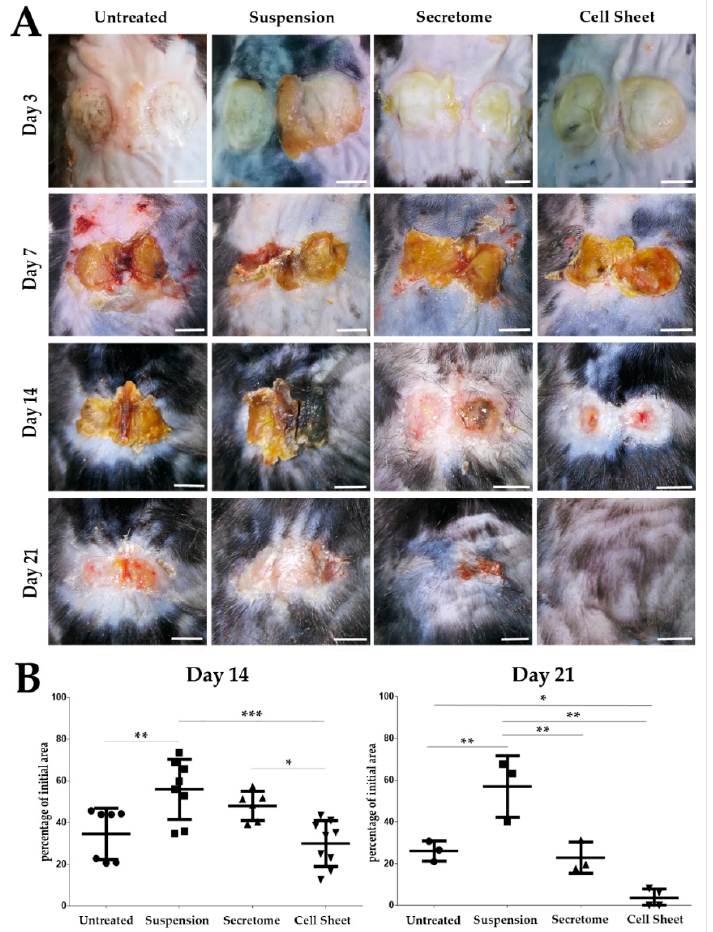
Figure 1. Macroscopic evaluation of pressure ulcer closure in experimental groups. ( A ) At Day 21 after cell sheet transplantation we found complete closure of the defect and onset of hair growth at the site of treated pressure ulcer. Scale bar represents 5 mm. ( B ) Results of defect relative area measurement as % of initial pressure ulcer at Days 14 and 21. Days 3 and 7 showed no significant di ff erence between groups (*— p < 0.05; **— p < 0.01; ***— p <